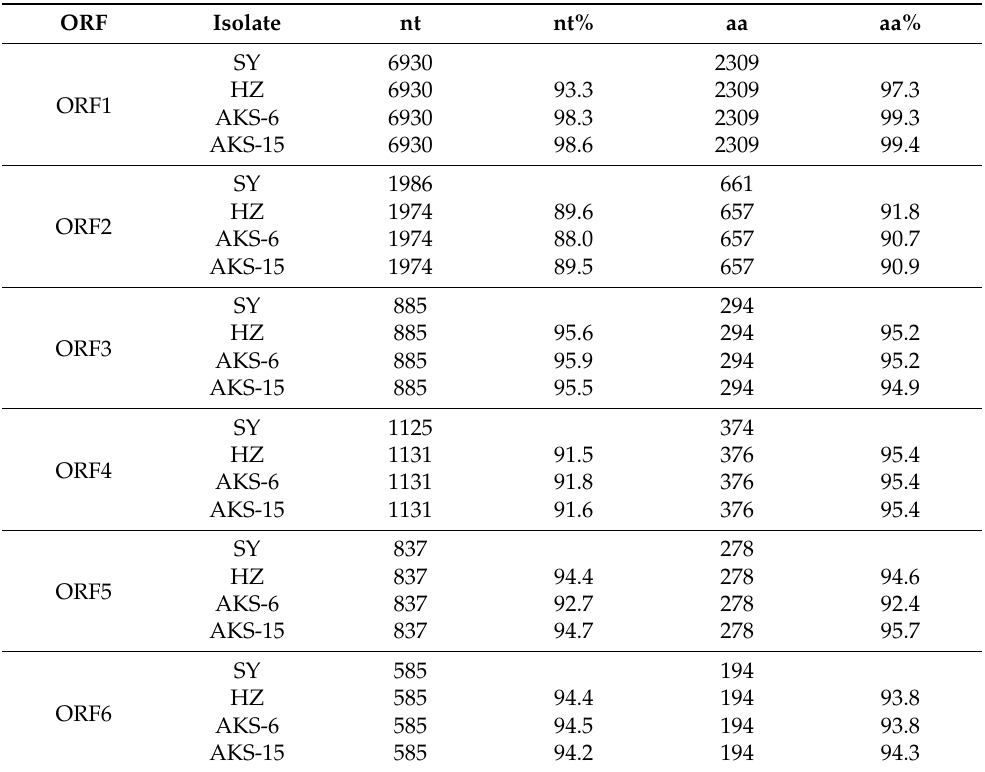
Table 2. The nucleotide and amino acid sequence comparison of six ORFs of JYMaV Aksu isolates HZ, AKS-6 and AKS-15 with those of reported isolate